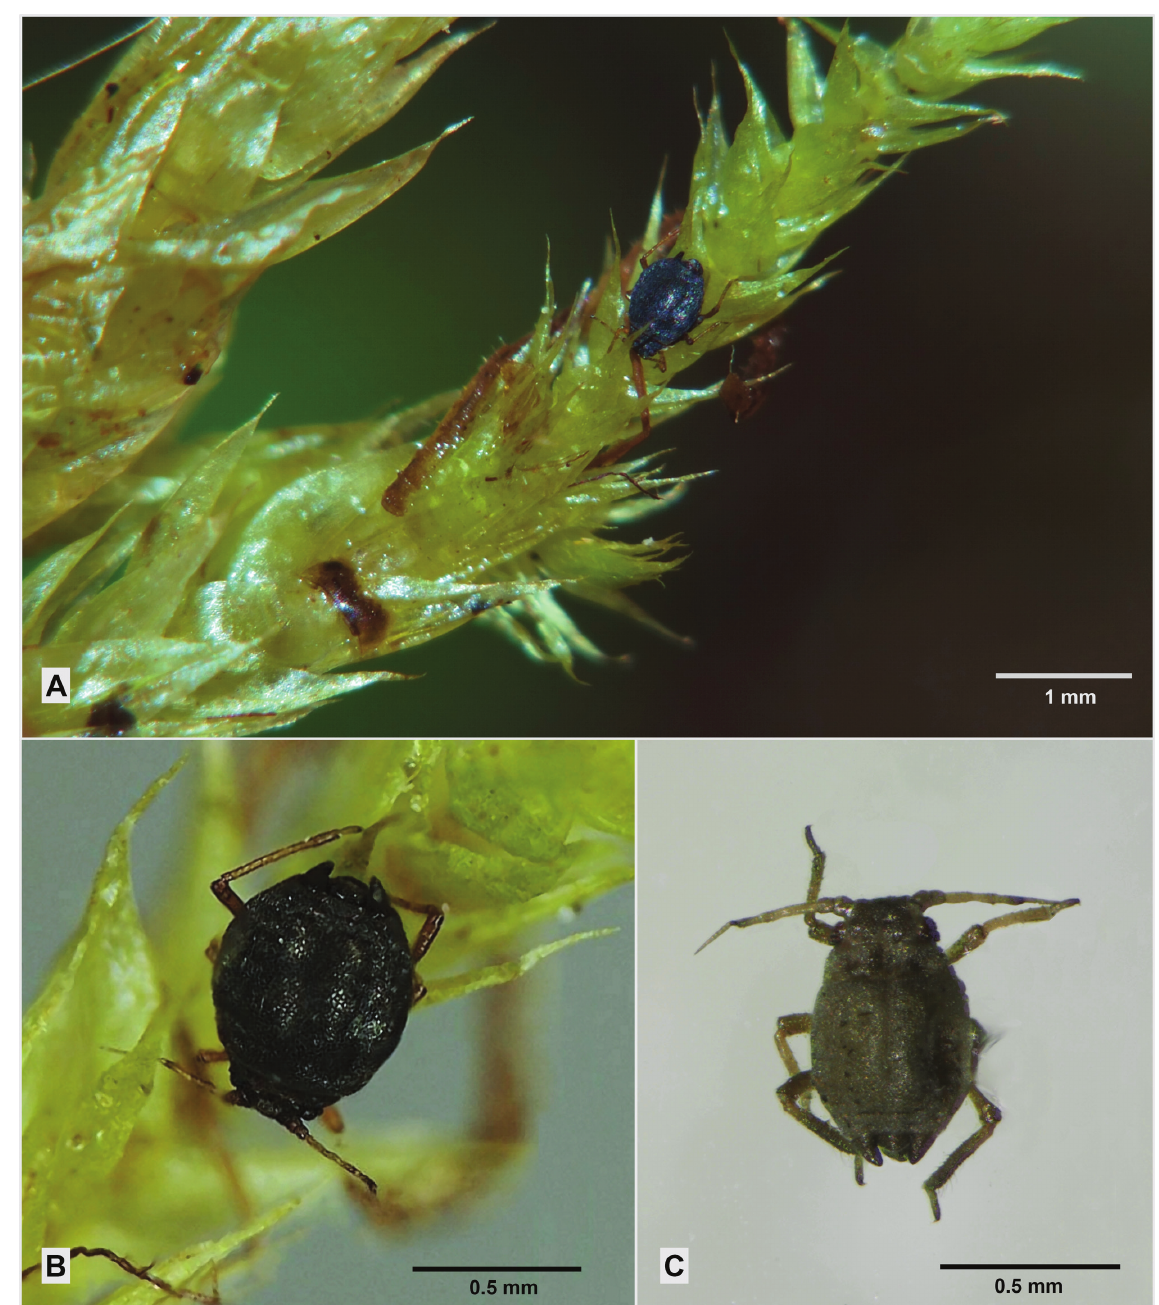
Fig. 14. Muscaphis cuspidata (Stroyan, 1955). A–B . Apt. on Brachythecium rivulare. C . Ovip on Brachythecium rivulare